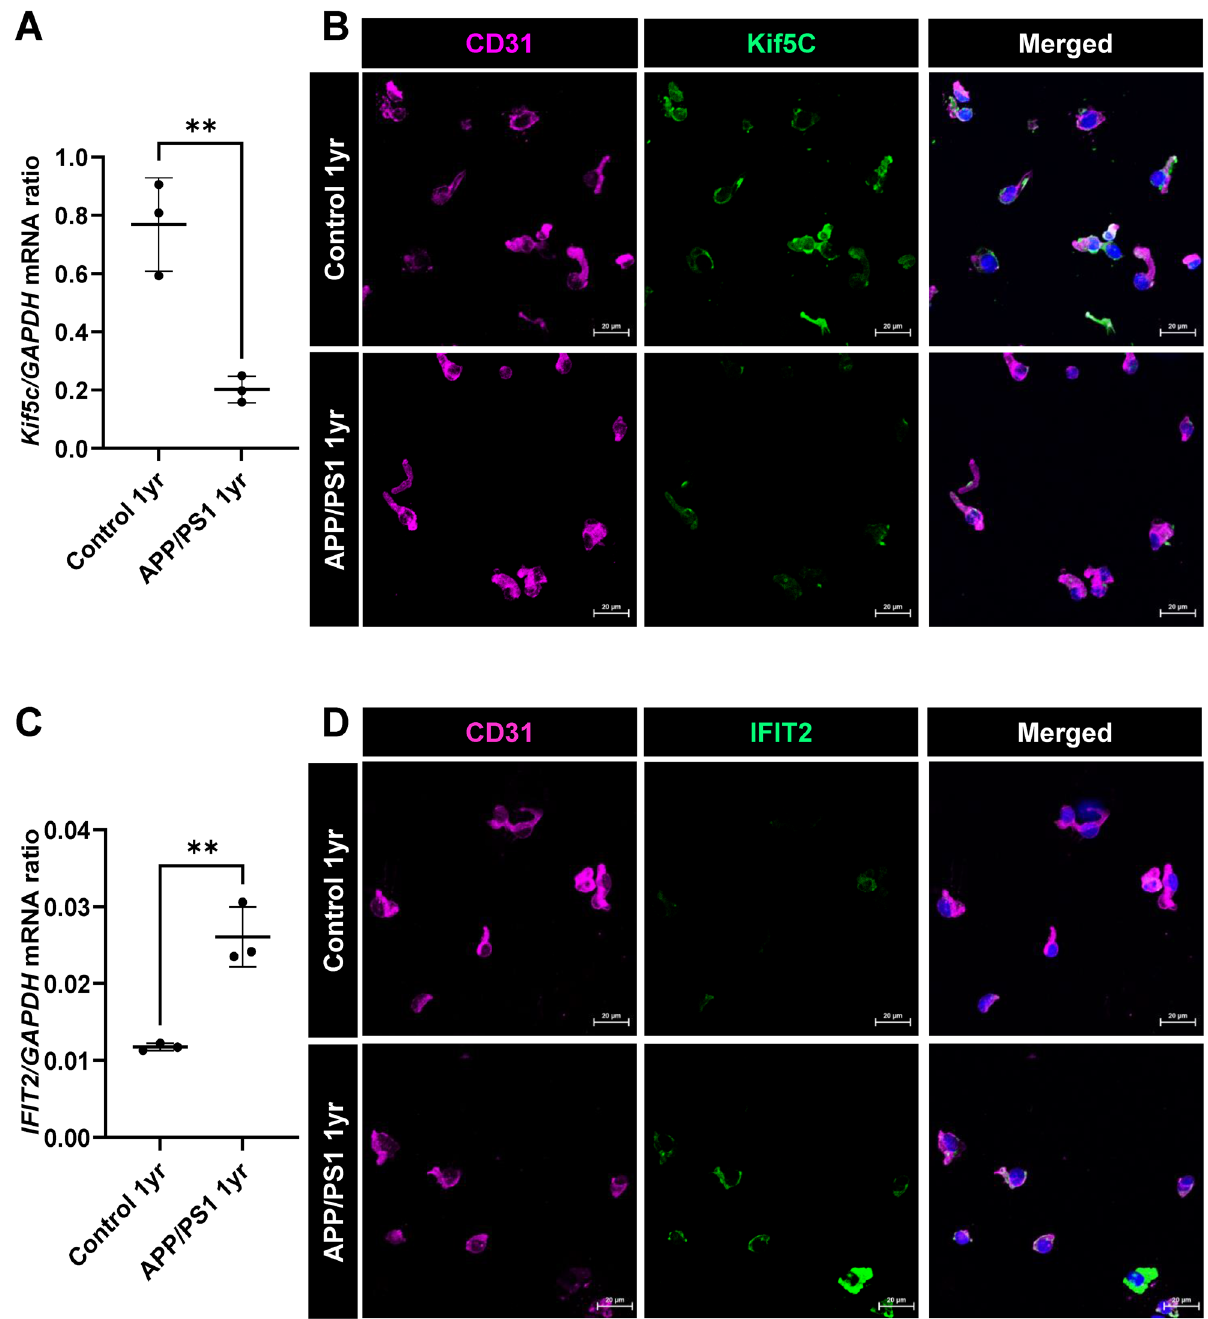
Figure 4. Validation of transcriptomic changes in the brain endothelium of APP/PS1 female mice. qPCR of RNA-Seq data based on log fold change and gene expression levels in brain EC of 1 year old APP/PS1 female and age-matched female control mice. Endothelial cells from the cortex of 1 year old APP/PS1 female mice demonstrated decreased Kif5c ( A ) and increased IFIT2 ( C ) gene expression supporting the RNA-Seq data. Data are represented as means and SD for three biological replicates and analyzed by Student’s T-test. ** p = 0.0041; 0.0032 respectively. GAPDH is used as a housekeeping gene. ( B , D ) Representative confocal images of cytospin of brain EC from cortex of 1 year old APP/PS1 female and age-matched female controls further validated the qPCR results. Scale bar 20